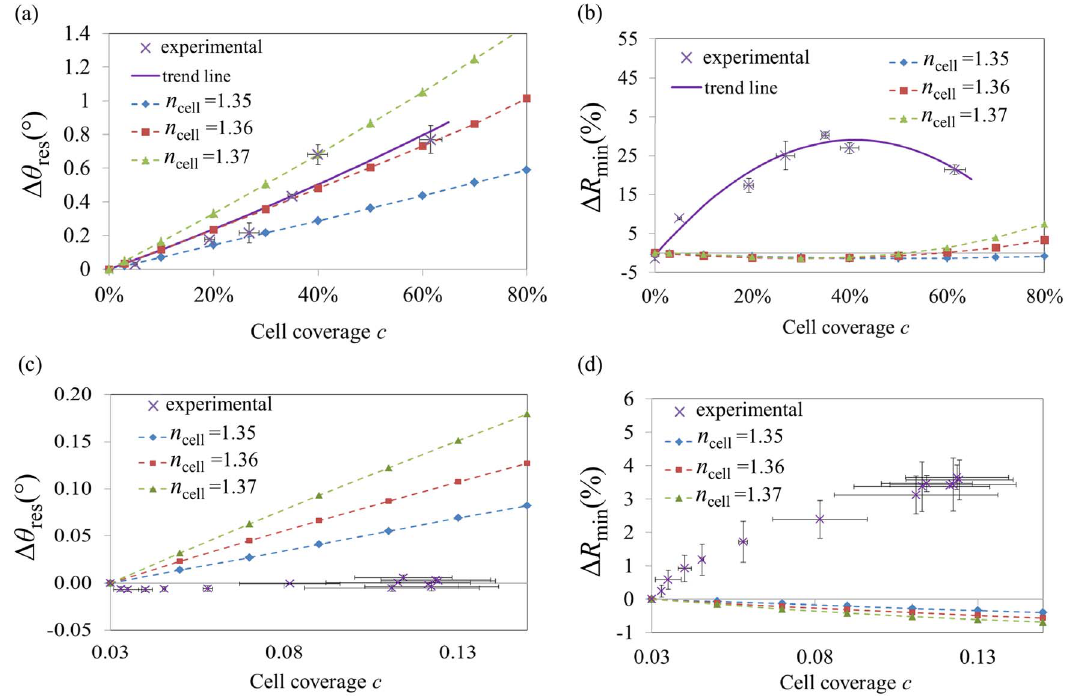
Figure 6. Comparison of LRSPR parameters from experimental studies to those predicted by the effective-RI LRSPR model. Dependence of h res (a) and R min (b) with respect to the cell coverage. Dependence of h res (c) and R min (d) with respect to the spreading of cells. The simulations are plotted in dashed curves ( n cell =1.35: diamond, n cell =1.36: squares, n cell =1.37: triangles). The linear fitting in (a) yielded n cell =1.360. Error bars represent the standard errors.